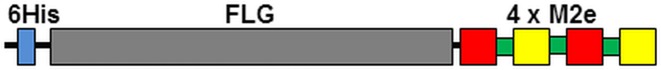
Structure of recombinant protein Flg-2M2eh2M2ek.Blue box, 6 histidine tag; grey box, flagellin of S. typhimurium; red boxes, human “consensus” M2e peptide; yellow boxes, M2e peptide of avian influenza strain А/Chicken/Kurgan/5/05 (H5N1); green boxes, flexible glycine-rich linkers. Sizes of boxes are not drawn to scale.